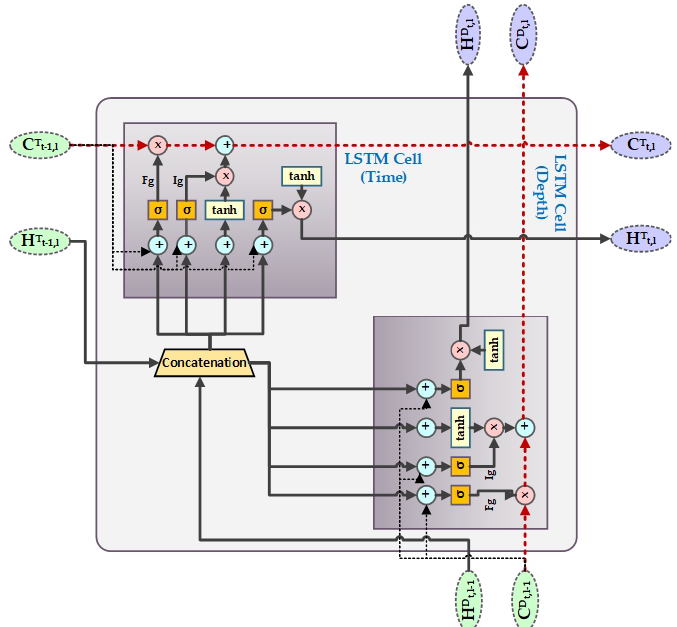
Figure 5. Grid Long Short-Term Memory (GridLSTM)